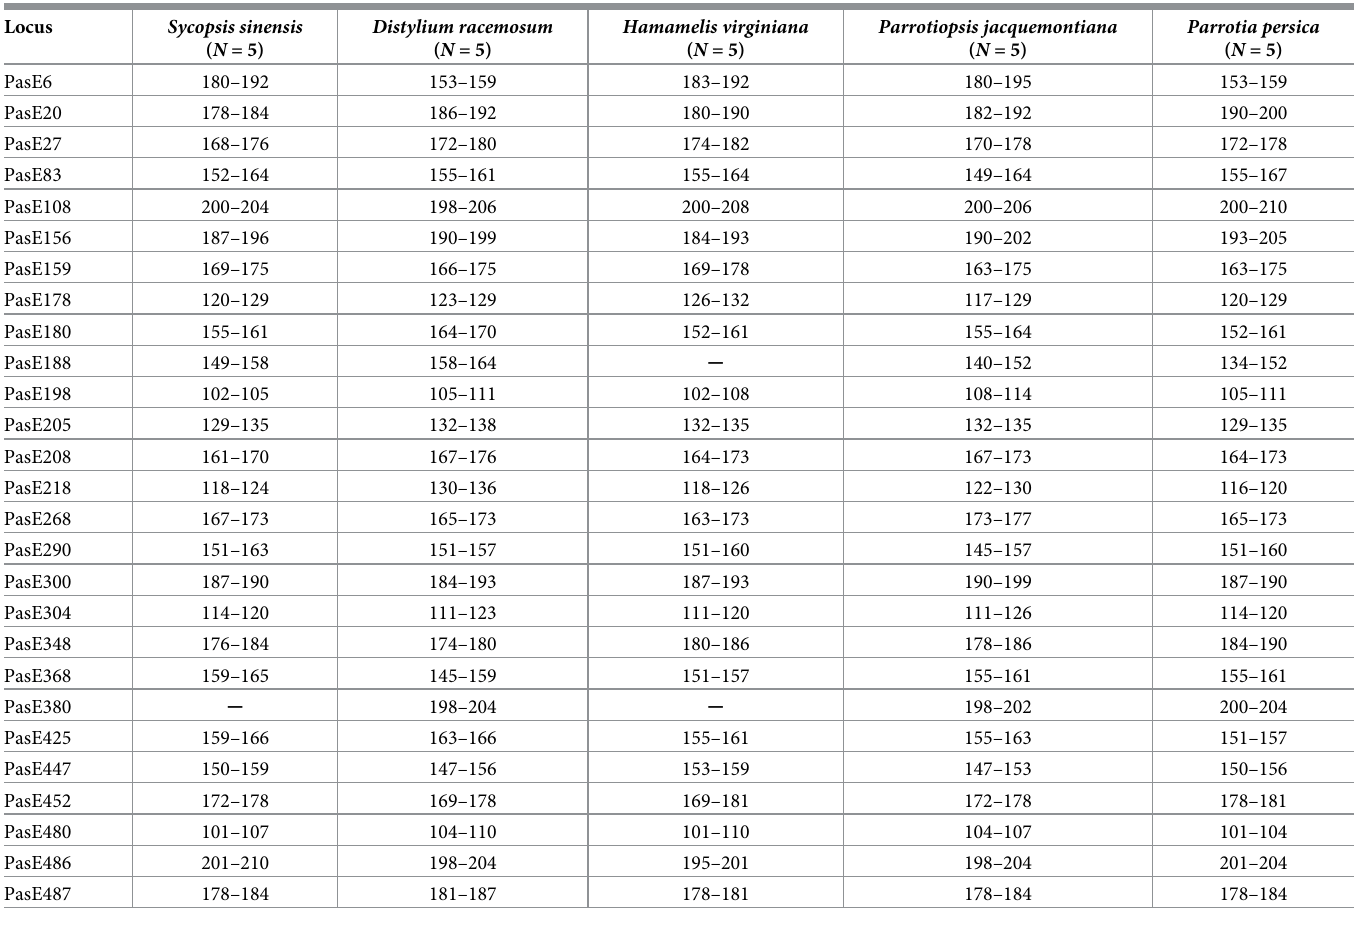
Table 3. Fragment sizes detected in cross-amplification tests of the 27 EST-SSR markers in the related five species of the Hamamelidaceae group. a